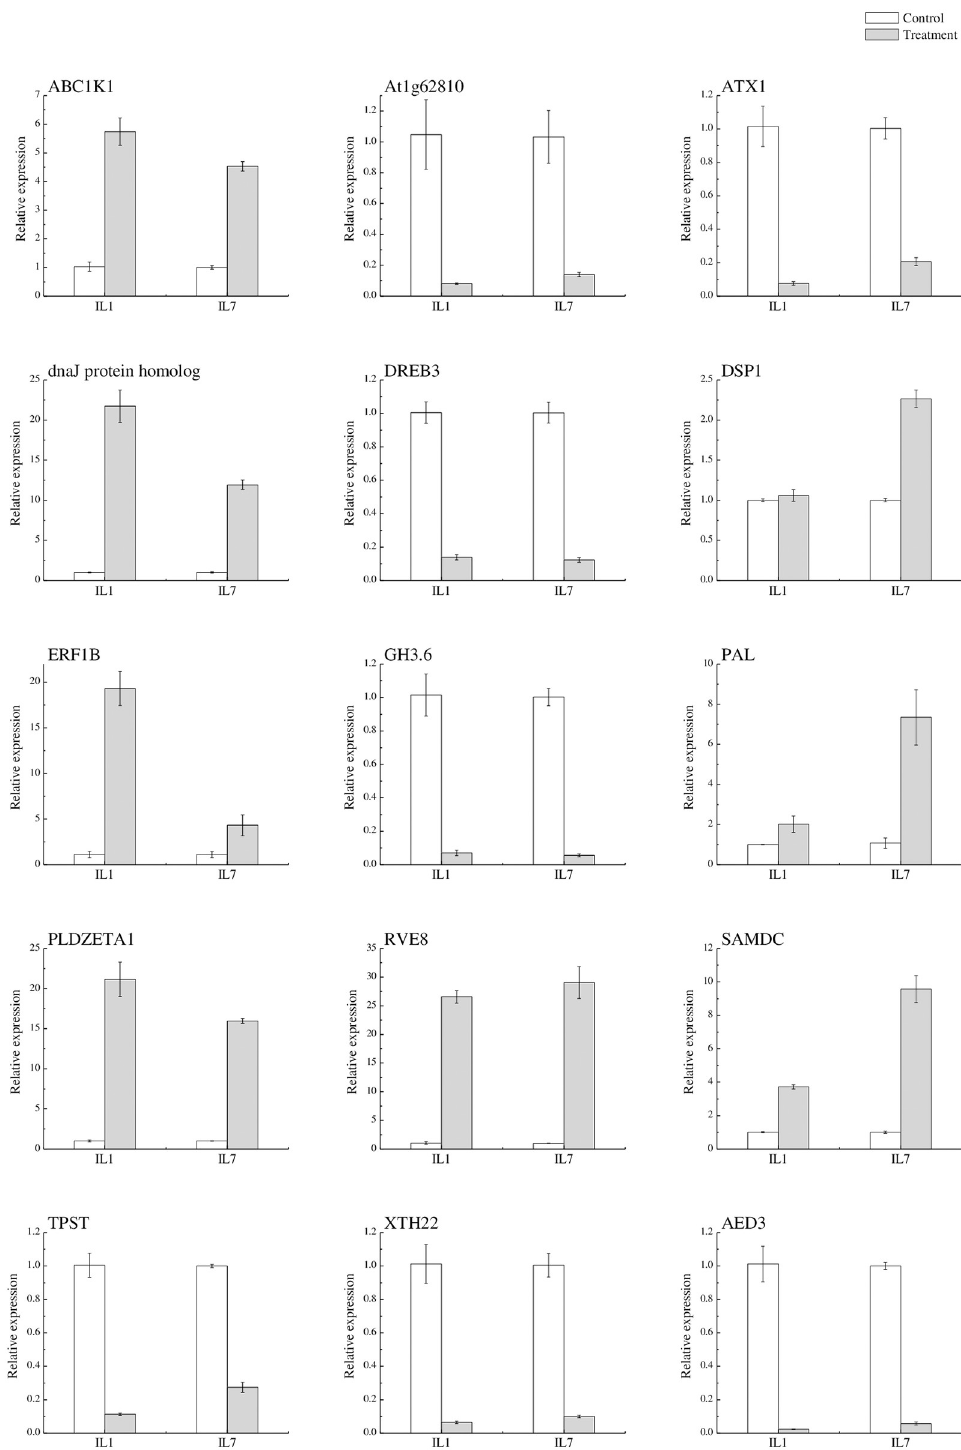
Fig 6. The quantitative RT-PCR results from IL7. Relative quantification was obtained through 2 - ΔΔ CT method using Actin reference gene. Data represent the average from three biological replicates and the error bars indicate the standard deviation ( ±